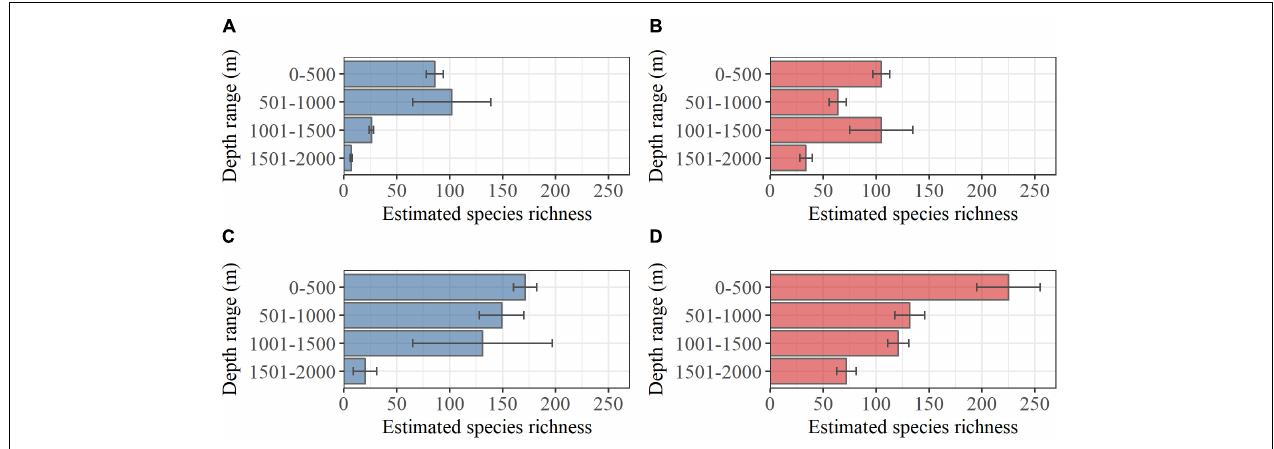
FIGURE 2 | Estimated species richness within 500 m depth intervals based on (Chao, 1987). Error bars represent standard errors of the estimates based on Chiu et al. (2014) for (A) bivalves north of the GIF ridge and (B) bivalves south of the GIF ridge, (C) gastropods north of the GIF ridge and (D) gastropods south of the GIF